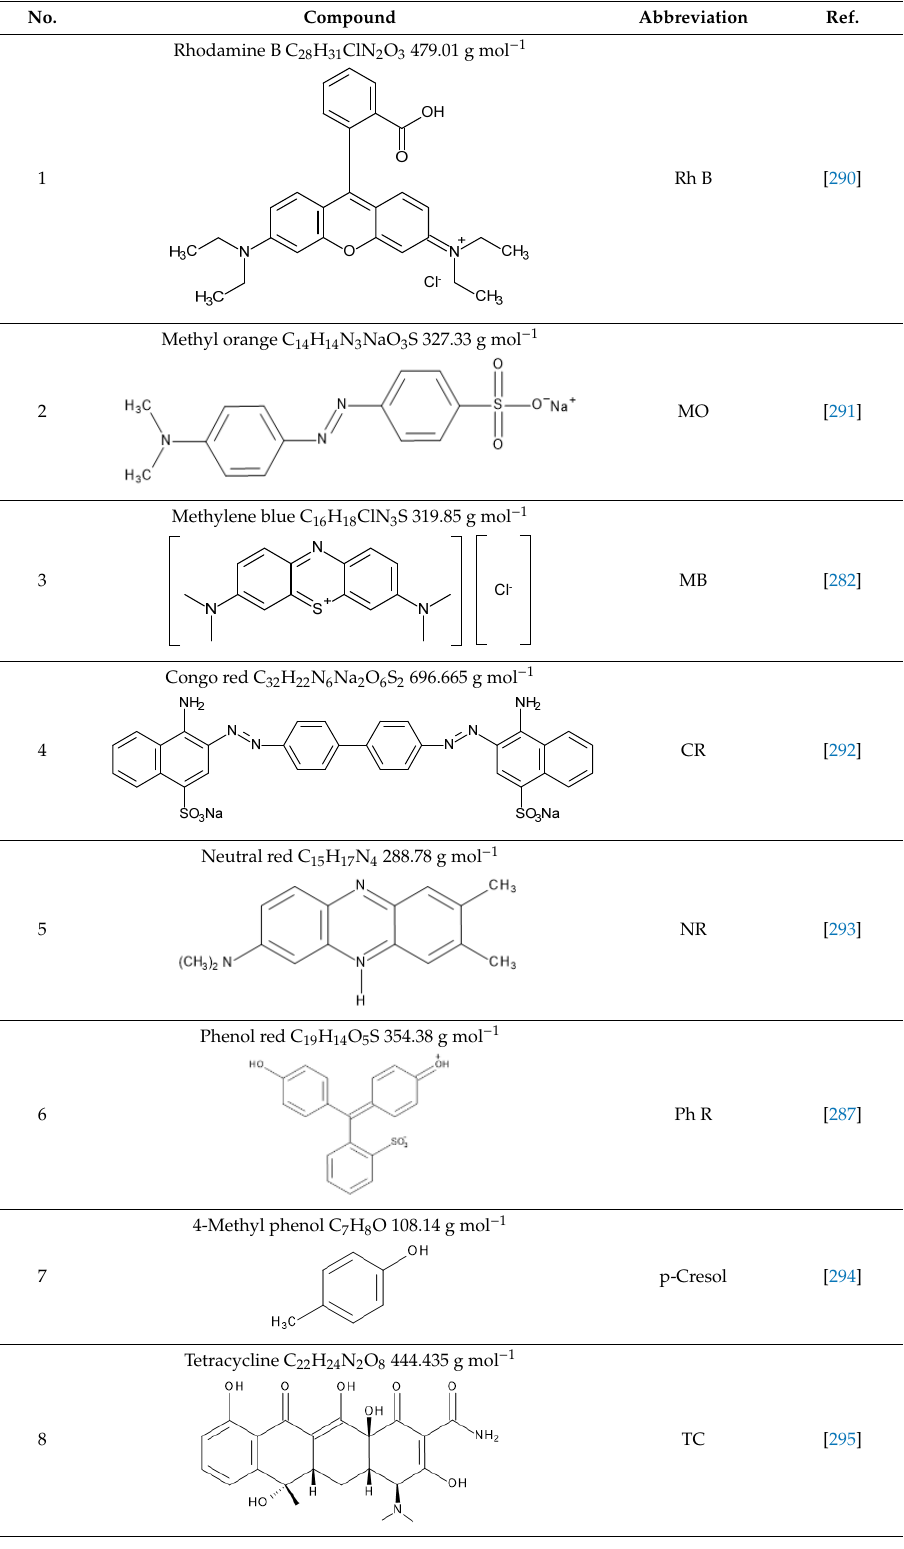
Table 12. Chemical structures of some organic pollutants.